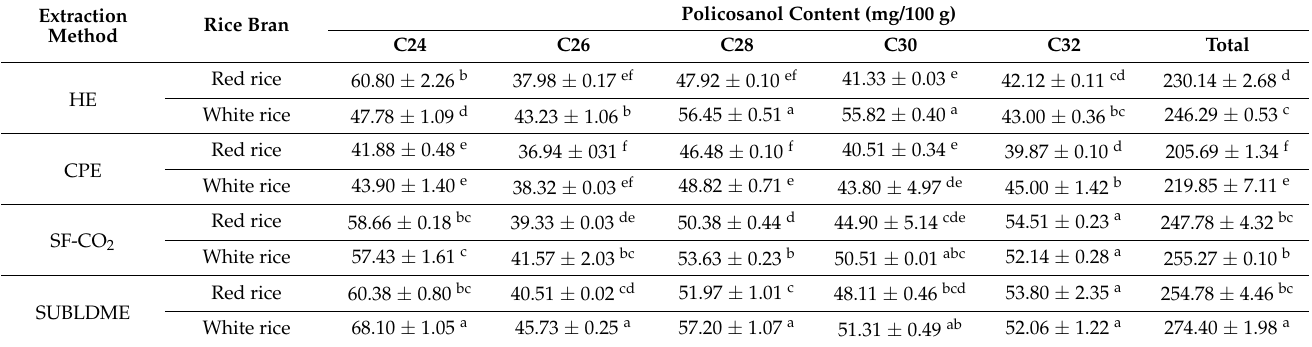
Table 6. Policosanol content of crude rice bran oil extracted using various extraction